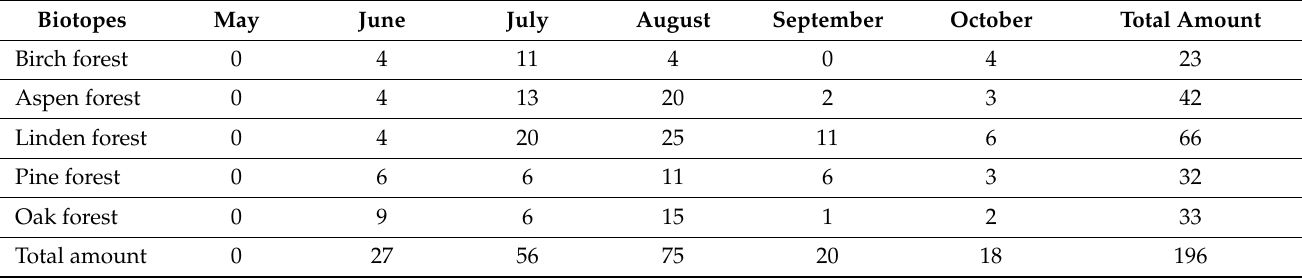
Table A8. Seasonal dynamics of Amiota semivirgo in five biotopes.